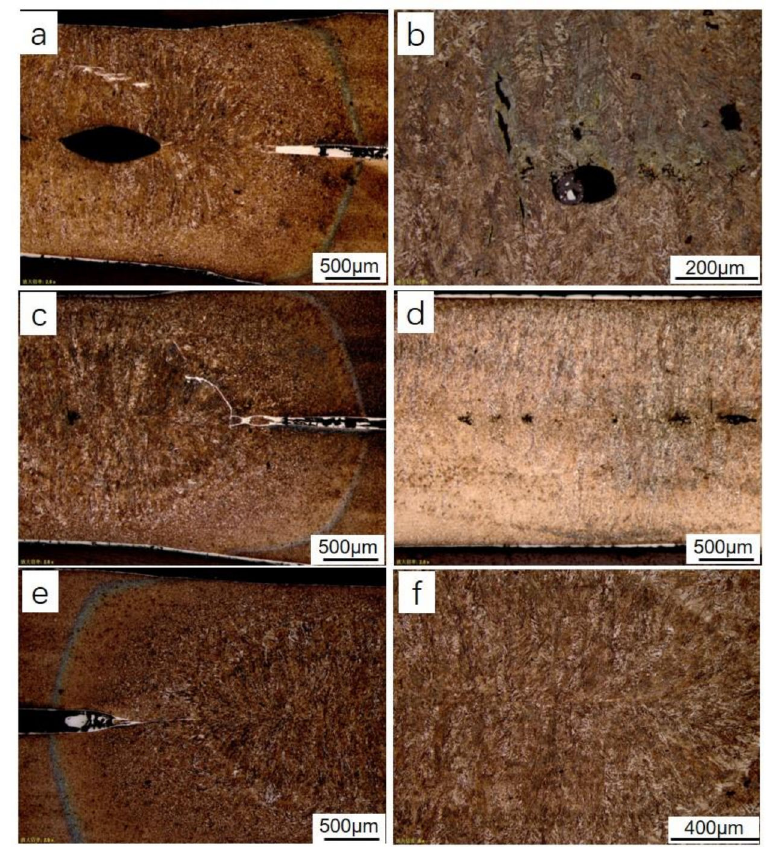
Figure 12. Various defects produced in spot welded specimens applying AC and DC, showing shrinkage holes, Al-Si inclusions, and cracks: ( a ) and ( b ) AC condition, ( c ) and ( d ) DC condition, ( e ) and ( f ) AC-6